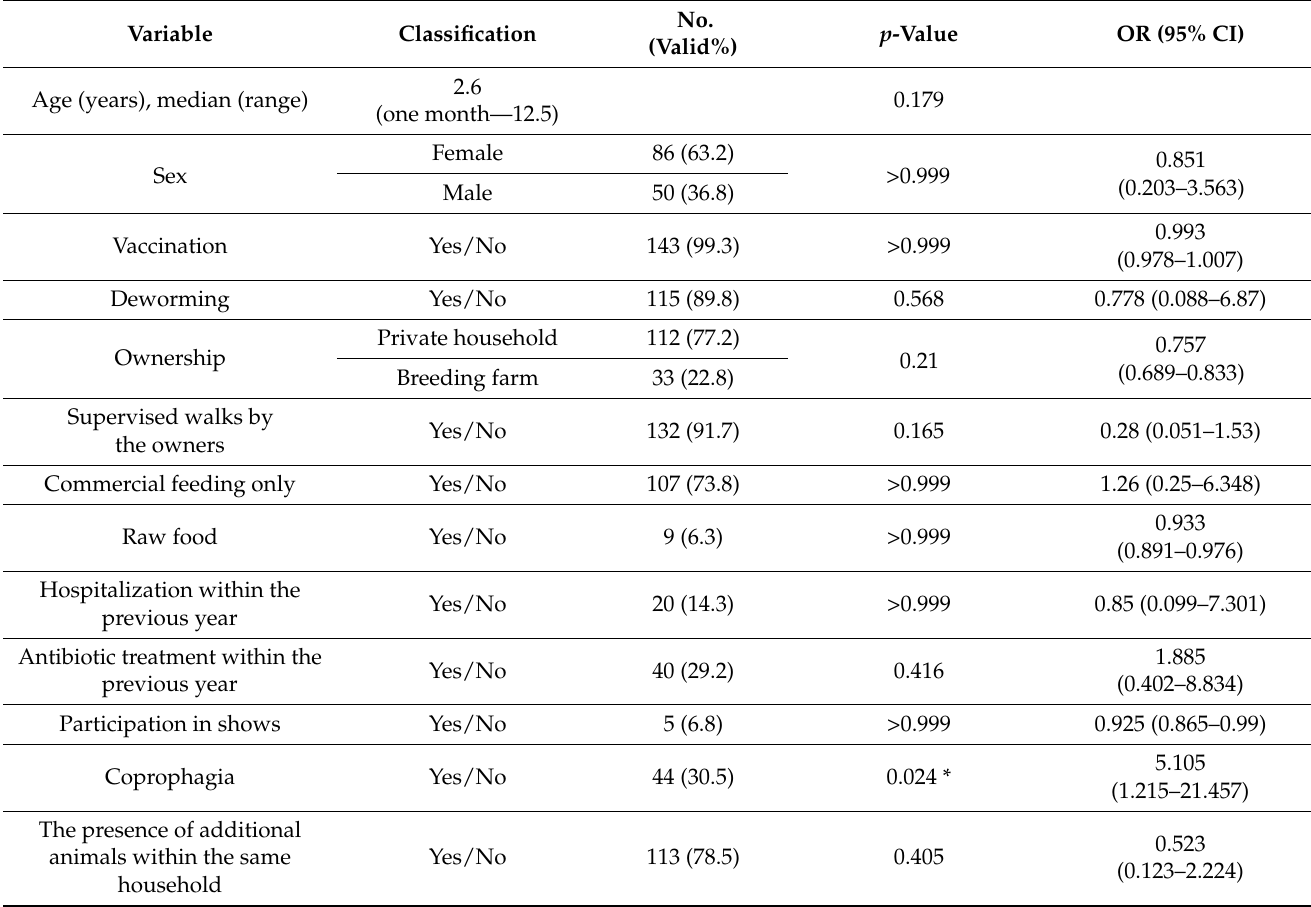
Table 3. Univariable analysis of ESBL-PE gut colonization by healthy community